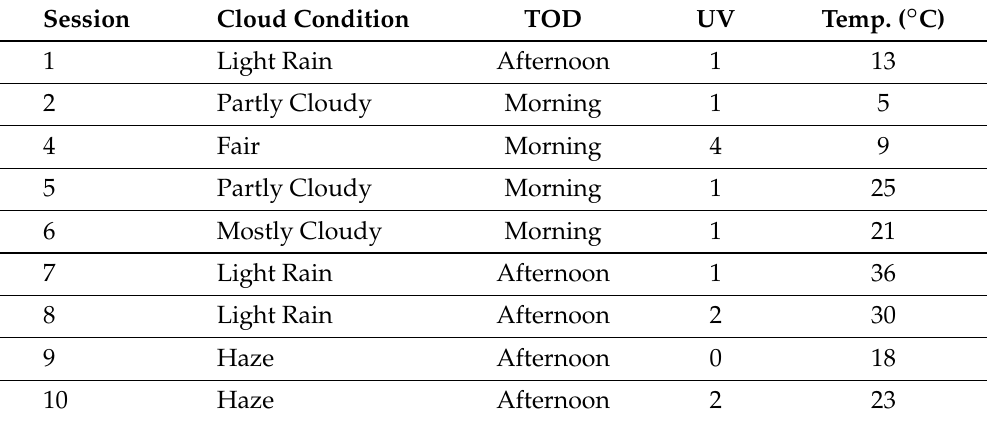
Table 1. Weather conditions for OSU thermal